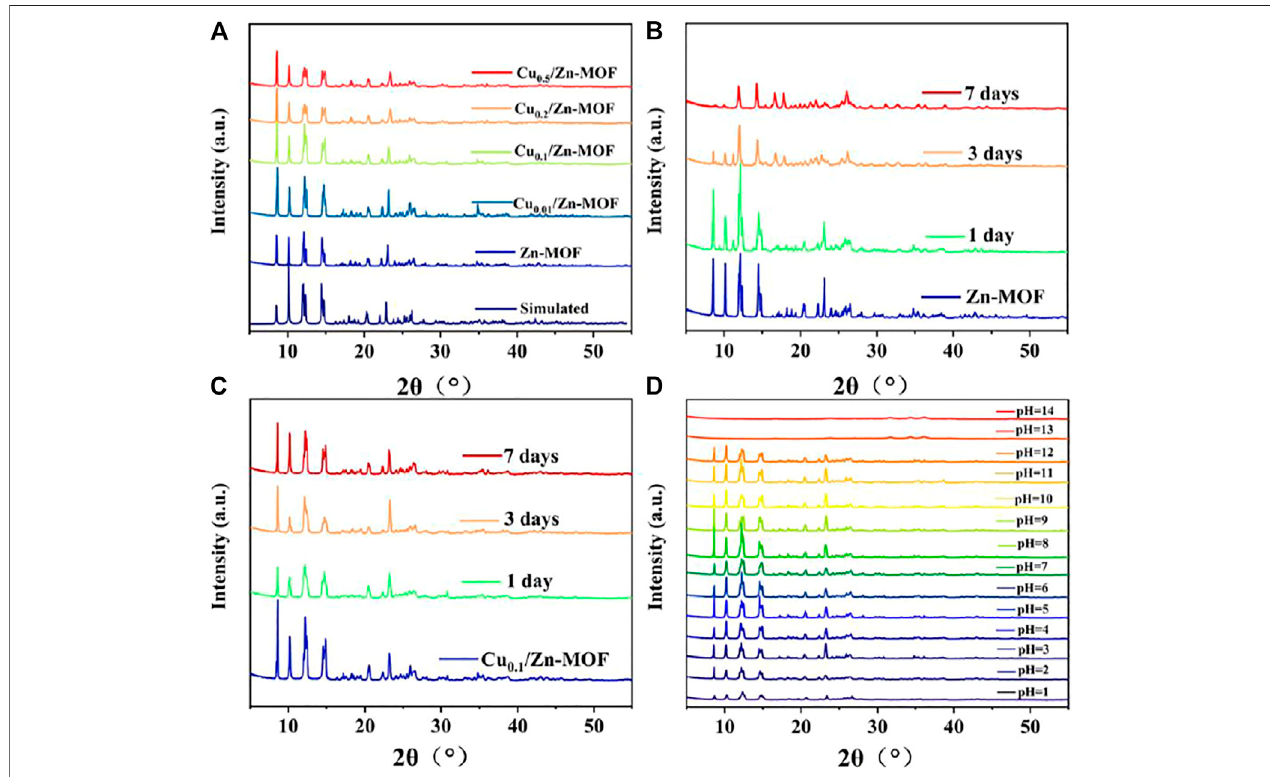
FIGURE2|(A) PXRDpatternsof Zn-MOF andCu x /Zn-MOF(x=0.01,0.1,0.2,and0.5).PXRDpatternsofZn-MOF (B) andCu 0.1 /Zn-MOF (C) soakedinwaterfor 1, 3, and 7 days, respectively. (D) PXRD patterns of Cu 0.1 /Zn-MOF soaked in different pH (1 – 14) solutions for 1 h.